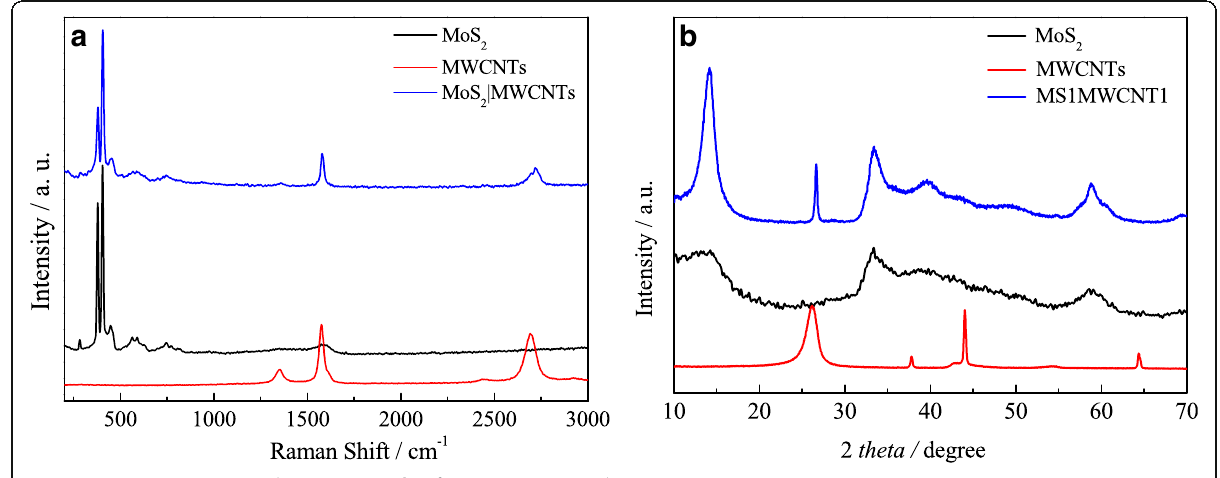
Fig. 2 Raman spectrum ( a ) and XRD patterns ( b ) of MWCNTs, MoS 2 , and